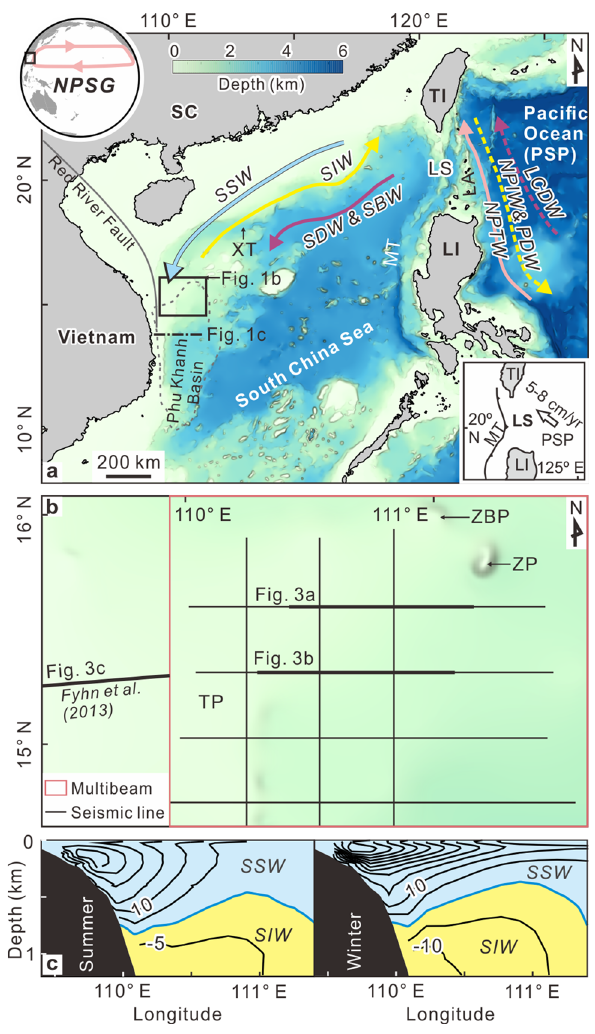
Figure 1. (a) Study area location (black rectangle) including water mass circulation. The black arrow marks the sense of movement of the plate. The gray line shows the location of Red River Fault. Dotted gray lines show the boundaries of Phu Khanh basin. Dotted-dashed line marks the hydrographic line in panel (c) ; (b) data used in this study, including bathymetric survey and surface trace of seismic surveys; and (c) observations of 20-year average current velocity (cm/s) from 1992 to 2011 (data were provided by Huijie Xue), where positive velocity values denote southward flow and negative values denote northward flow. The blue line marks the zero contours. Contour interval is 5 m. TI Taiwan Island, LI Luzon Island, PSP Philippine Sea plate, LS Luzon Strait, LA Luzon arc, SC South China, MT Manila Trench, XT Xisha Trough, TP Triton platform, ZP Zhongjian platform, ZJB Zhongjianbei platform. Abbreviations for water masses given in text. Maps were generated using Surfer software (version 13, https ://www.golde nsoft ware.com/produ cts/surfe r) and CorelDraw Graphics Suite X8 (https ://www.corel draw.com/cn/). Elevation data source: ETOPO1 (https ://doi.org/10.7289/V5C82